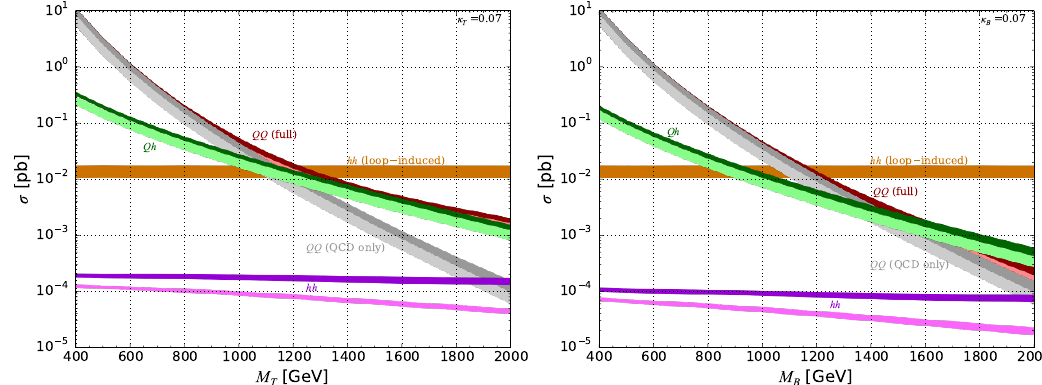
Figure 3 . Di-Higgs production cross sections at the LHC, for proton-proton collisions at a centre- of-mass energy of 13 TeV and for a benchmark scenario in which (cid:20) shown as a function of the VLQ mass and we consider up-type (left) and down-type (right) quark partners coupling to the (cid:12)rst generation. A detailed explanation of the various curves is given in the text. LO results (light colours) and associated error bands can be compared to their NLO counterparts (darker